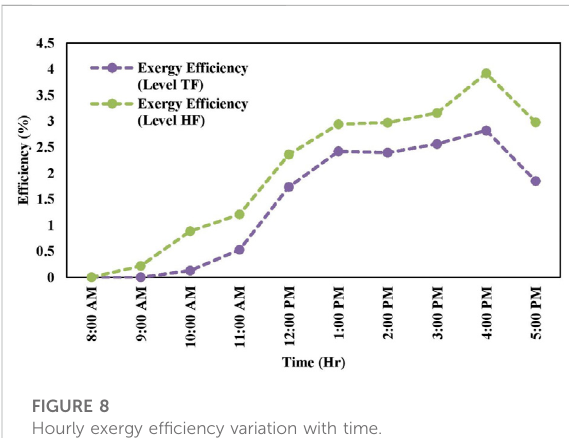
FIGURE 8 Hourly exergy ef fi ciency variation with time.